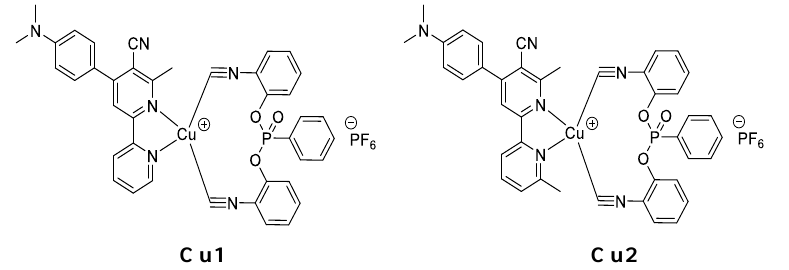
Figure 1. Copper complexes used in this work as PIs.